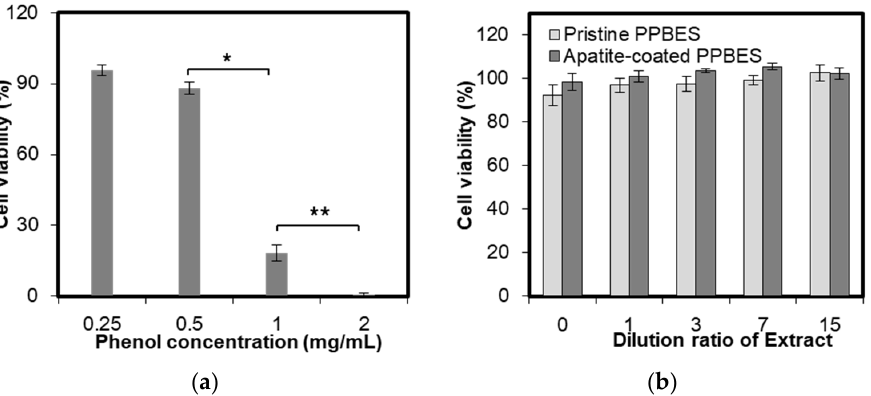
Figure 7. Cell viability incubated with phenol solution ( a ) and known concentrations of the aqueous-based extracts from pristine PPBES and apatite-coated PPBES ( b ). * and **: p < 0.05 relative to the phenol concentration 1 mg/mL.